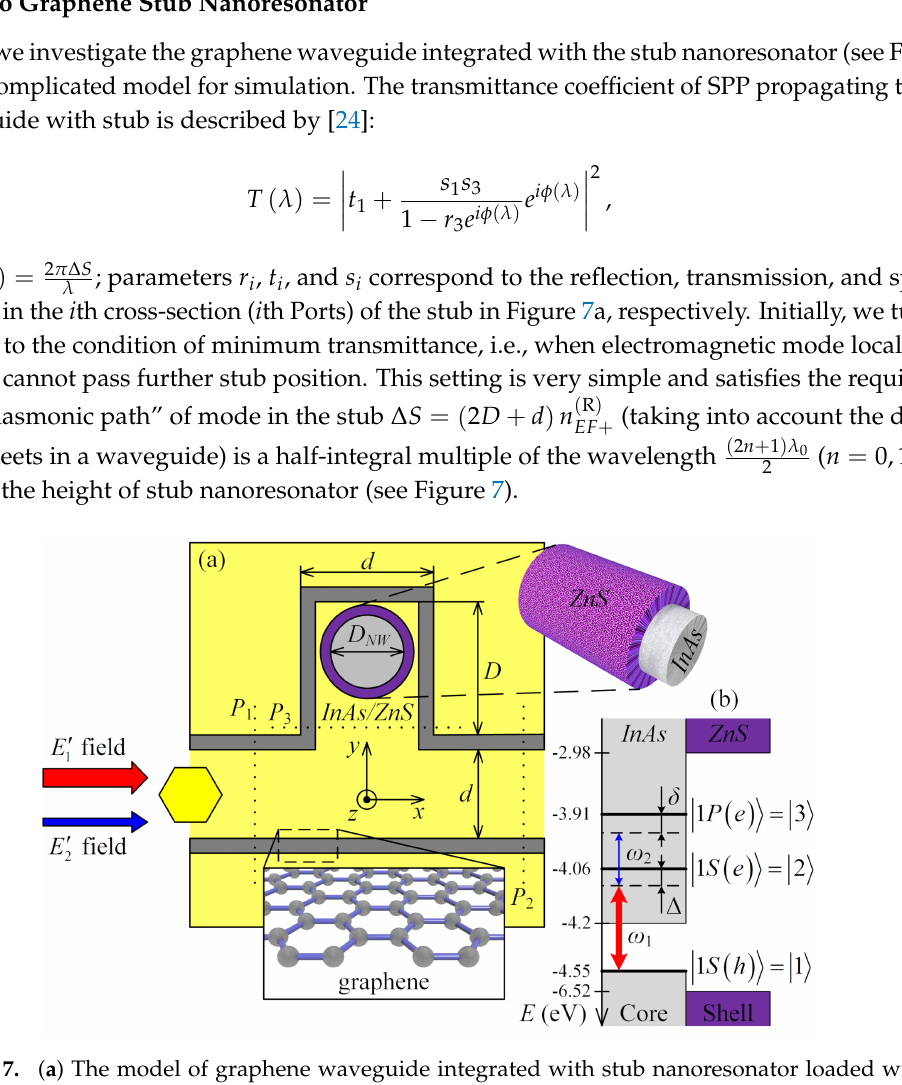
Figure 7. ( a ) The model of graphene waveguide integrated with stub nanoresonator loaded with core–shell NW. ( b ) The relative position between energy gaps and band offsets of InAs-ZnS bulk semiconductors, where E V 1 = − 4.55 eV for the top of the valence band and E C 1 = − 4.2 eV for the bottom of the conduction band in InAs; E V 2 = − 6.52 eV, E C 2 = − 2.98 eV the same in ZnS; the Ladder-type interaction scheme of two SPP modes with frequencies ω 1 (pump) and ω 2 (signal); and 9.9 nm core radius InAs/ZnS NW with energy levels E | 1 (cid:105) = − 4.55 eV, E | 2 (cid:105) = − 4.063 eV, and E | 3 (cid:105) = − 3.908